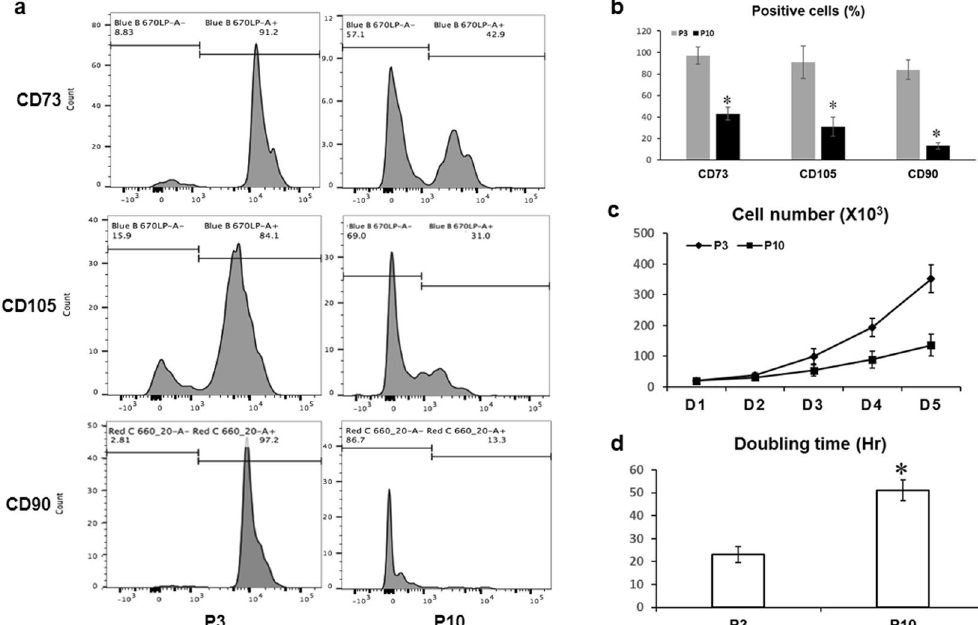
Figure 1. Long-term cell culture induces aging in MSCs. ( a ) Representative Flow Cytometry histograms showing CD73, CD105 and CD90 positive MSCs in cultured P3 and P10 MSCs. ( b ) Quantified percentage of CD73, CD105 and CD90 positive MSCs in P3 and P10 MSCs from 6 patients. ( c ) Representative growth curve of P3 and P10 MSCs from one donor. ( d ) Cumulative population doubling time (DT) of P3 and P10 MSCs is shown in hours (Hr). * P <